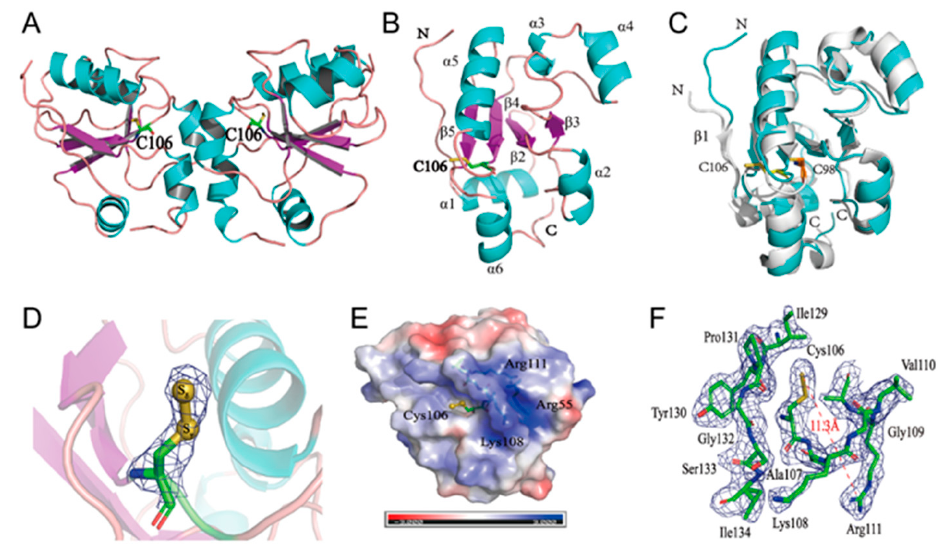
Figure 1. Crystal structure of RDL2 ( S. cerevisiae rhodanese 2). ( A ) The X-ray crystal structure of RDL2 was solved at 2.47 Å by molecular replacement using the RDL1 structure (PDB entry: 3D1P) as a template. The structure of RDL2 has two asymmetric chains. ( B ) The monomer of RDL2 consists of a four-stranded parallel β -sheet core (purple) surrounded by six α -helices (blue). Cys 106 is shown in stick representation. ( C ) Alignment of RDL2 structure (blue) with RDL1 ( S. cerevisiae rhodanese 1) structure (white). ( D ) The electron density map of active site cysteine. The persulfide bond is formed by the S γ atom of Cys 106 with a S δ atom. The electron density map (2Fo-Fc) is contoured at 1.5 σ . ( E ) The surface electrostatic potential representation of RDL2. Cys 106 is located in a peanut-like pocket of neutral electrostatic field. Arg 111 , Arg 55 and Lys 108 in the vicinity of the persulfide group form a positive electrostatic field. Positive and negative electrostatic potentials are shown in blue and red, respectively in the range of ±3 kT/e. ( F ) The distance between NH 3+ group of Arg 111 and S δ atom of Cys 106 is shown in red line. The distances between S δ atom and neighboring residues all exceed the hydrogen bond range.